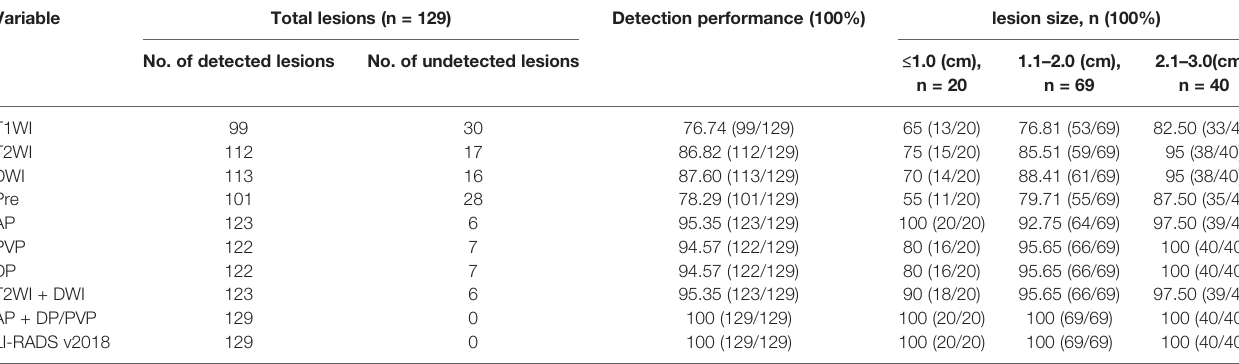
TABLE 4 | Detection performance of the MR sequence and aMRI protocols with ECA-MRI.